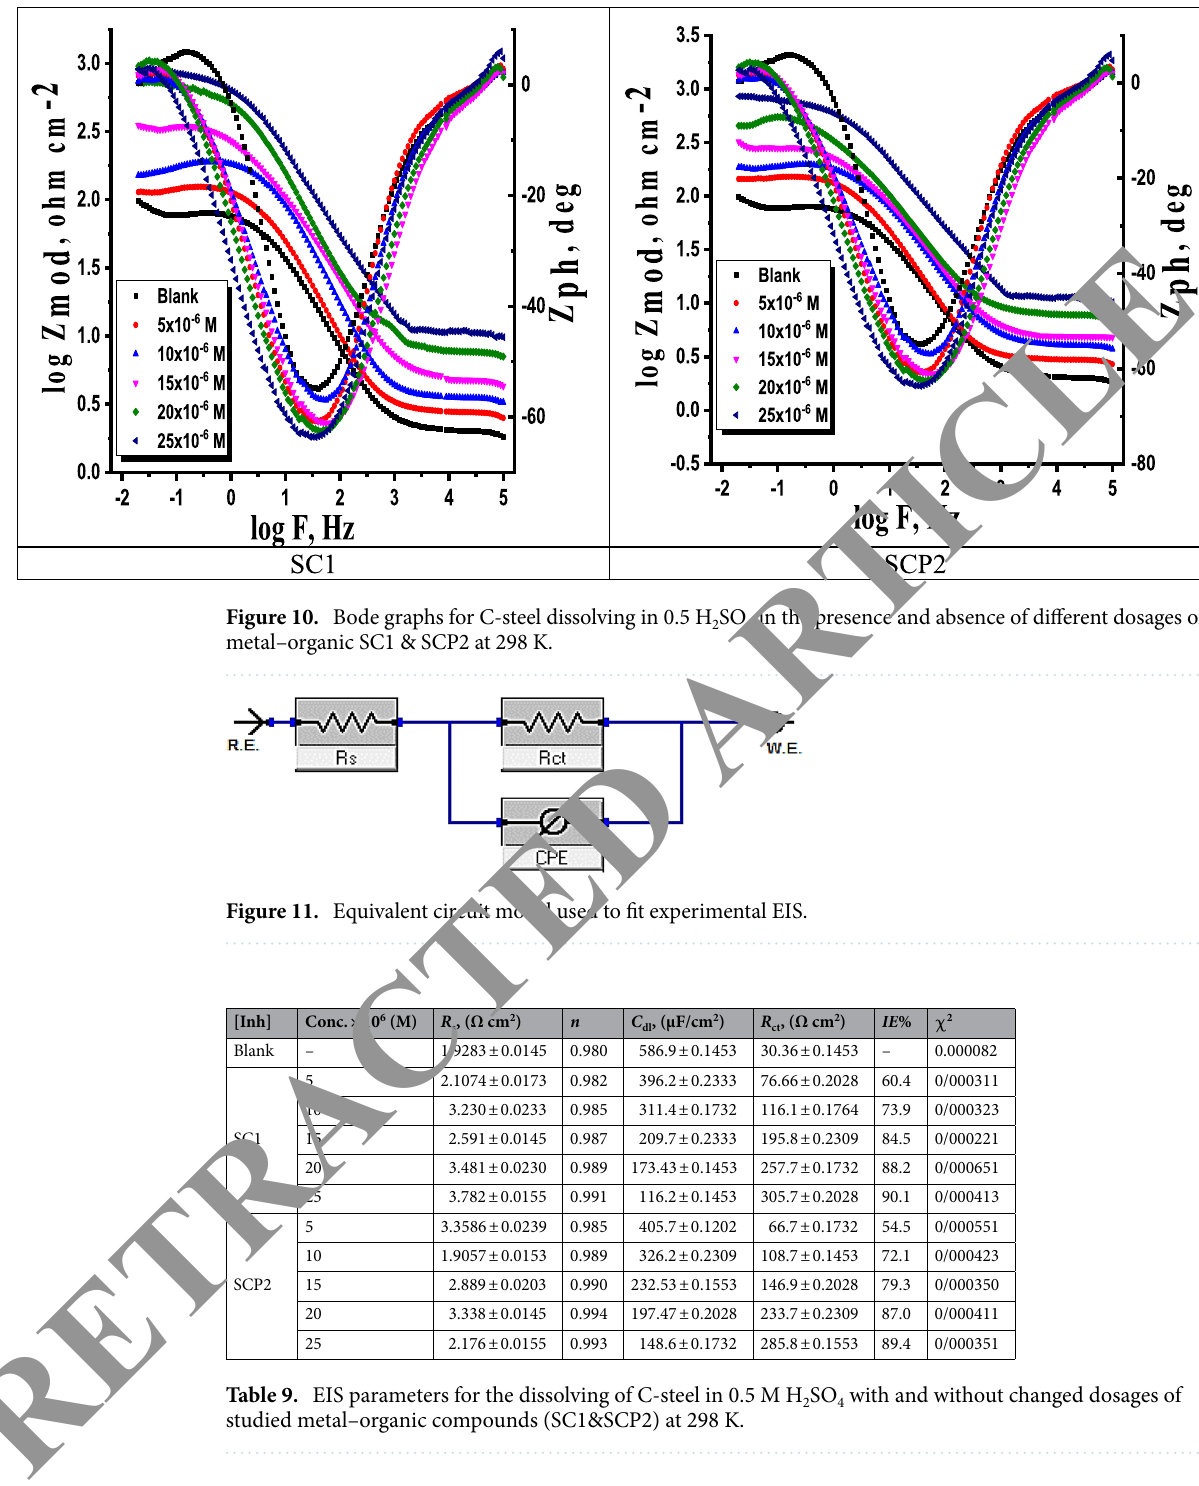
Table 9. EIS parameters for the dissolving of C-steel in 0.5 M H 2 SO 4 with and without changed dosages of studied metal–organic compounds (SC1&SCP2) at 298 K.